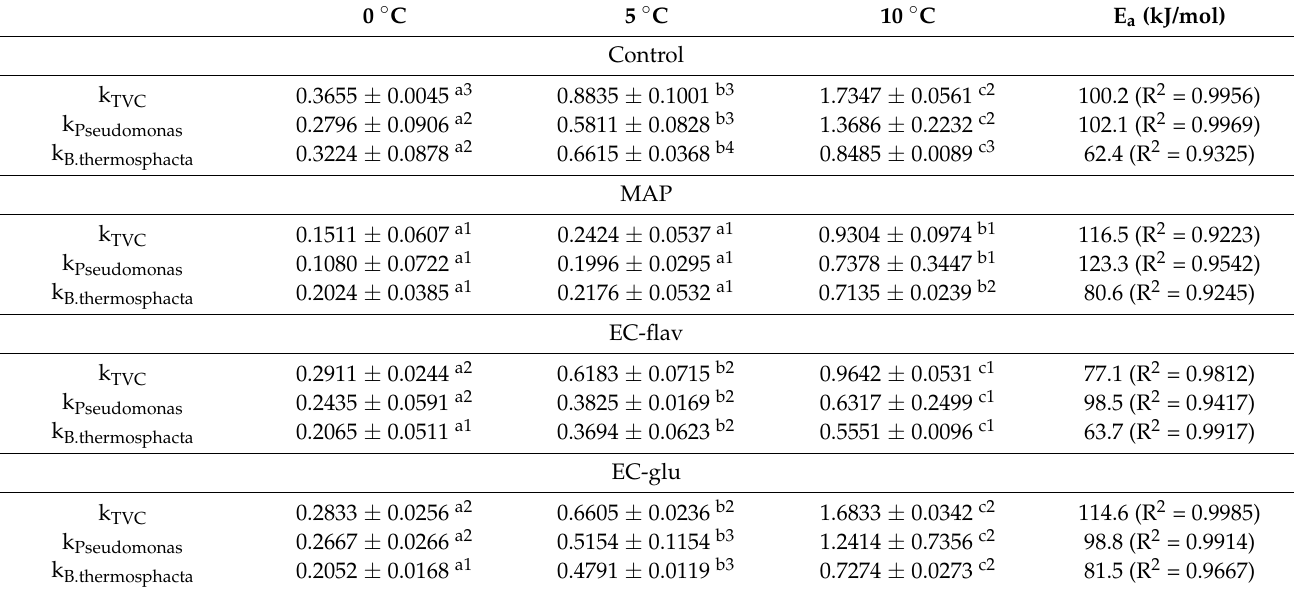
Table 2. Microbial growth rates (k in d − 1 ) for chicken thighs stored at 0, 5, and 10 ◦ C, and activation energy (E a ) values calculated by the Arrhenius